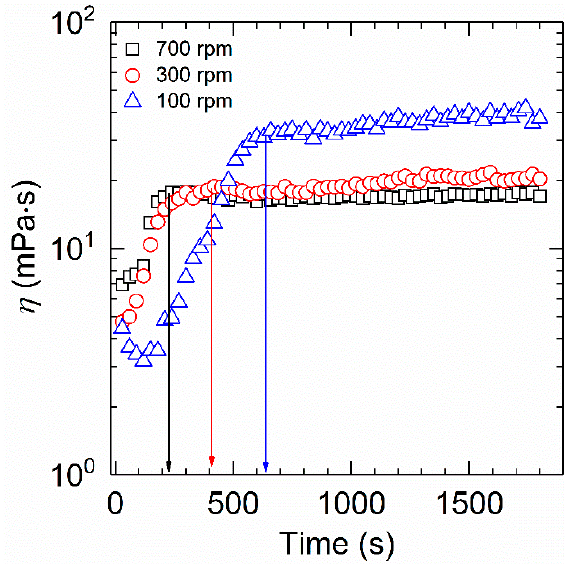
Figure 4. Determination of dissolution time of 1000 mg ⋅ L − 1 HVFR at 30 °C.